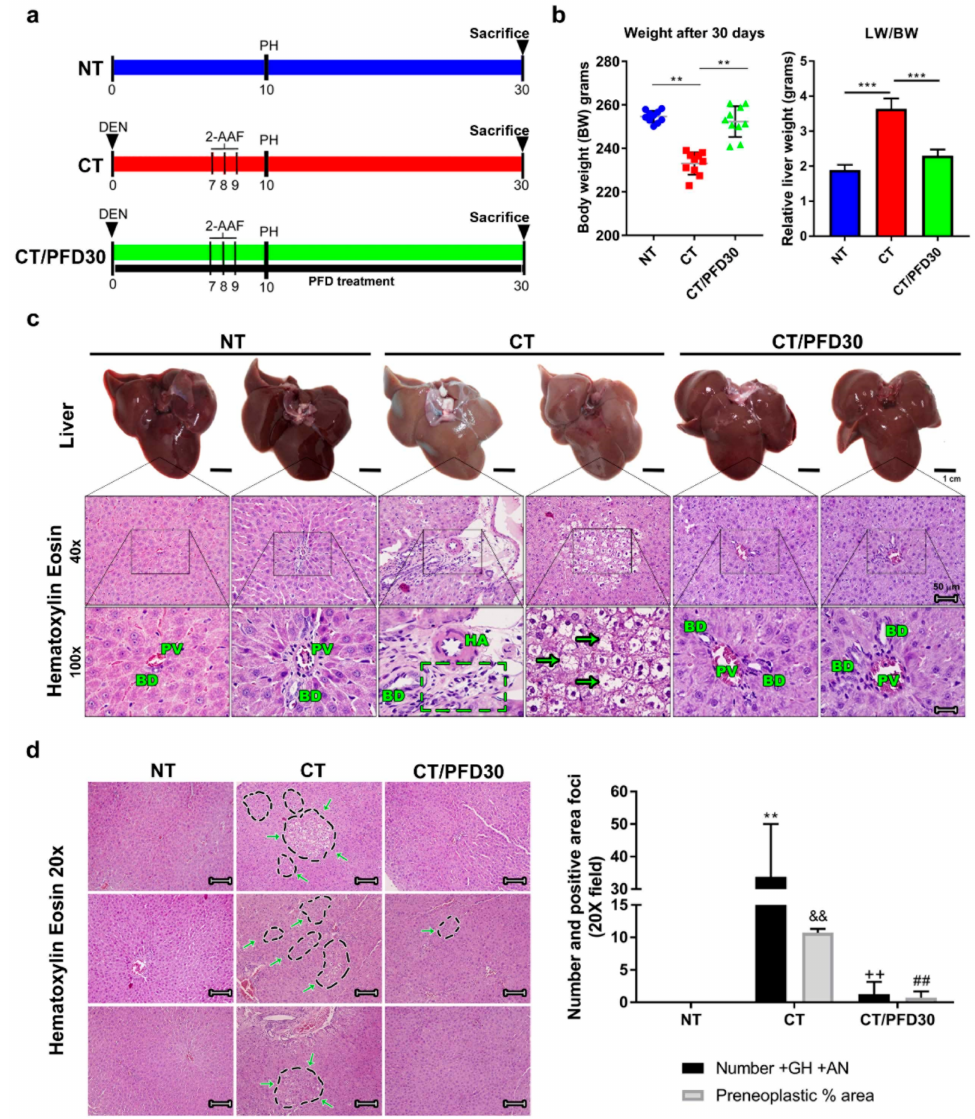
Figure 2. PFD administration can prevent chemical-induced pathological damage. ( a )